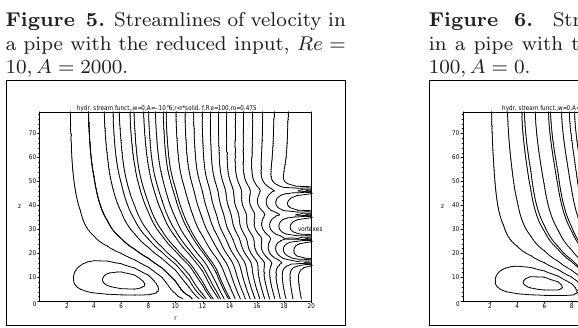
Figure 7. Streamlines of velocity in a pipe with a ring input, Re = 100 ,A = 2000 .